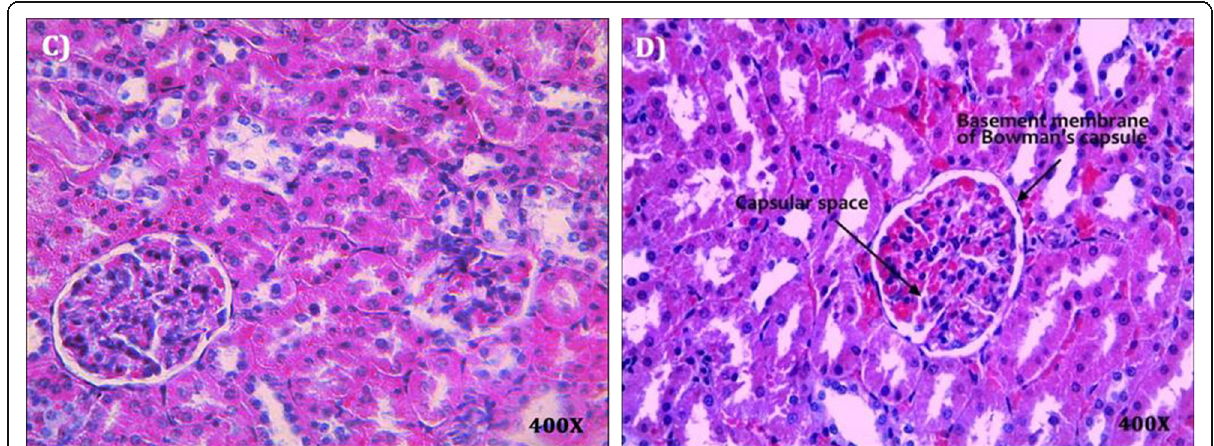
Fig. 2 Light micrographs of rat kidney tissue in ( c ) control group and ( d ) treated